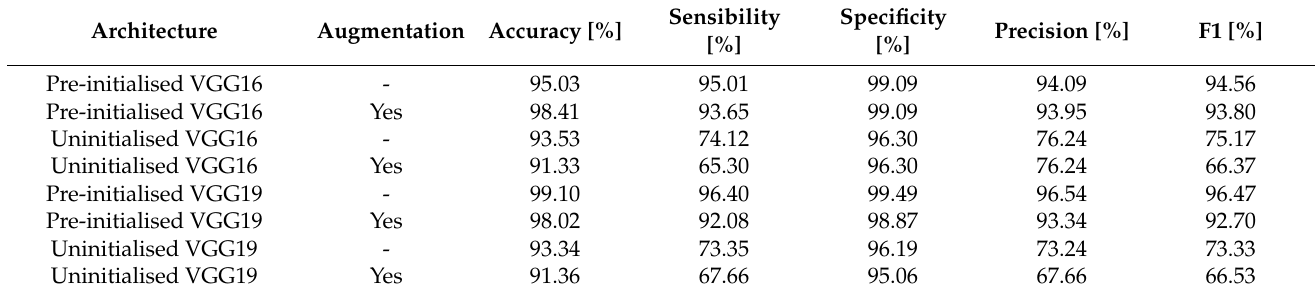
Table 7. VGG training results.